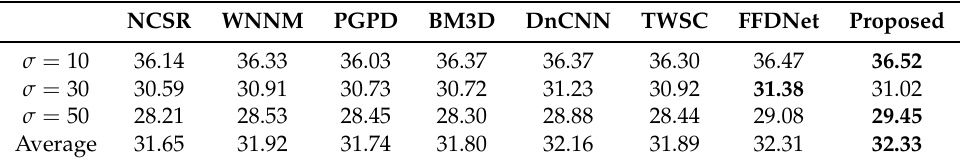
Table 7. Average PSNRs (dB) of the competing methods for images in the ESPL synthetic image database with noise level σ = 10, 30 and